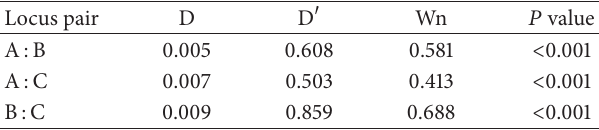
Table 3: Global linkage disequilibrium (D 󸀠 and Wn) values in Yunnan